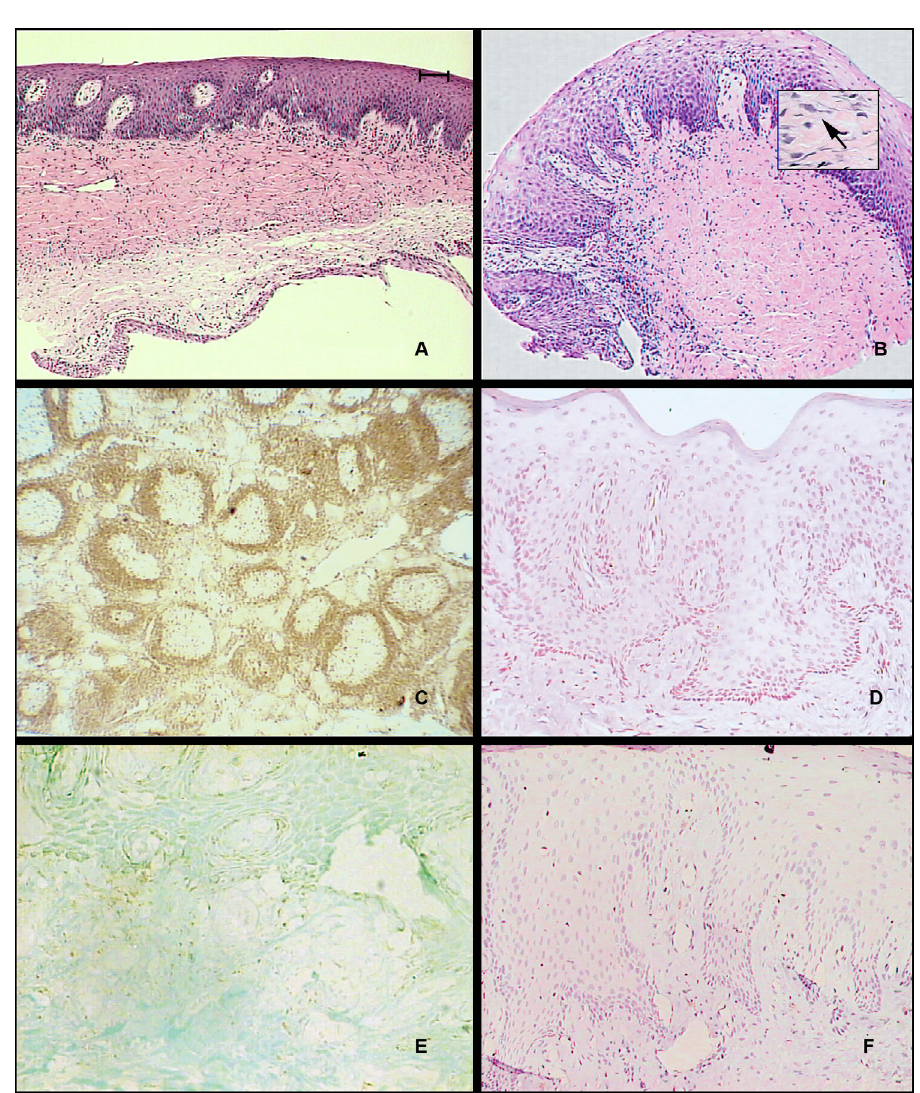
Figure 4- Photomicrographs of hematoxylin and eosin and bcl-2 immunostaining. (A) Gingival sample of the control group. HE. (Bar=50 m m). (B) Gingival sample of the phenytoin group, 120 days. In detail, fibroblast-like cell (arrow). (C) Positive control of bcl-2 immunoreaction in histological section of spleen of capuchin monkey ( Sapajus spp ). Original Magnification x10. (D) Negative control in histological section of gingiva of capuchin monkey. Hematoxylin counterstaining. Original Magnification x20. (E) Immunoreaction against bcl-2 in